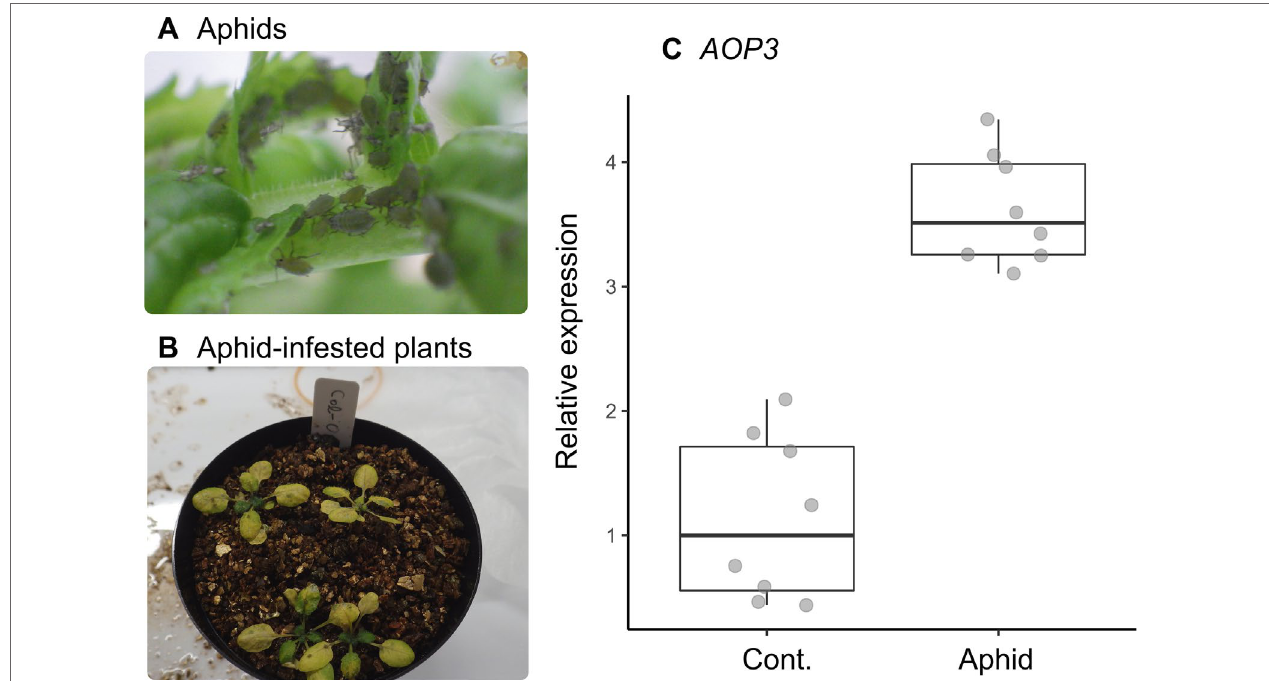
FIGURE 4 | Inducible response of AOP3 to the specialist mustard aphid L. erysimi in the laboratory-grown A. thaliana Col-0 accession. (A) Photograph of a laboratory-reared colony of L. erysimi . (B) Aphid-infested seedlings on Col-0 accession plants. (C) Relative expression of AOP3 in RT-qPCR analysis of aphid- infested and control plants; seedlings were infested by aphids for 7 days (Aphid) or not infested